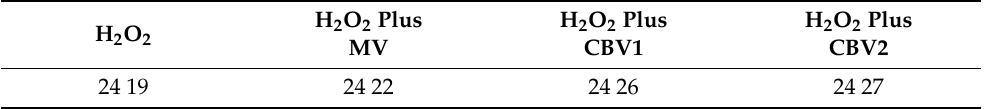
Table 2. Population doubling level (PDL) of citrus blended vinegars. H 2 O 2